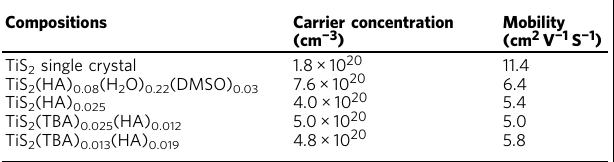
Table 1 Carrier concentration and mobility of TiS 2 single crystal and the hybrid inorganic/organic superlattices Compositions Carrier concentration (cm − 3